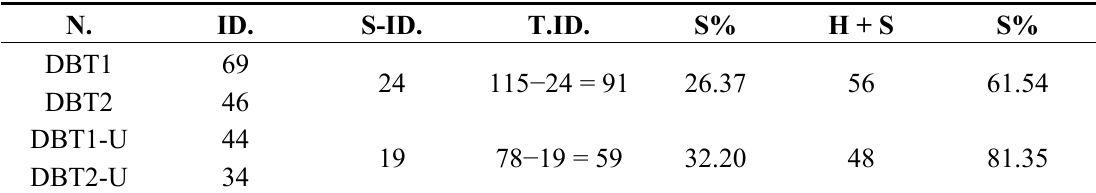
Table 3. The number comparison of the identified compounds between Danggui Buxue Tang 1 and Danggui Buxue Tang 2. N. ID.